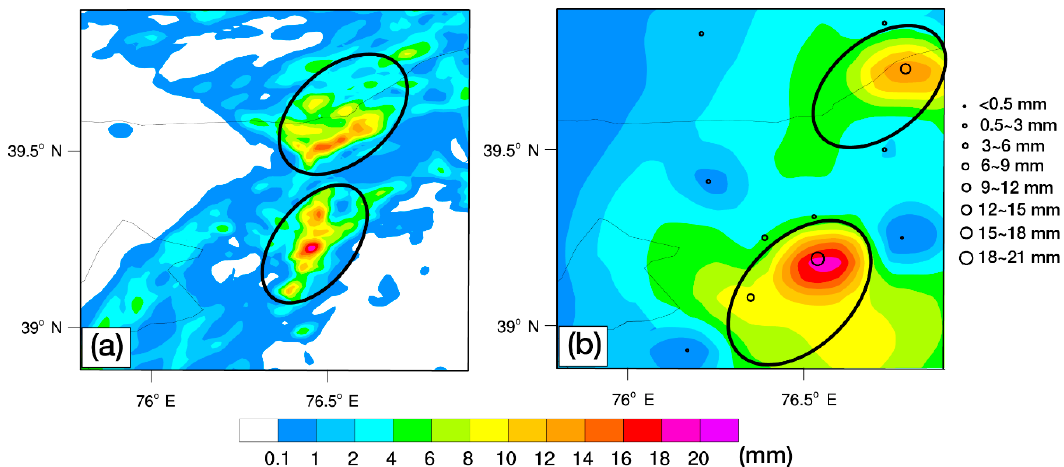
Figure 7. ( a ) Simulated 8-h accumulated precipitation (units: mm) from 1000 to 1800 UTC 23 June 2015. ( b ) 8-h accumulated precipitation (shading, units: mm) observed by the ground-based automatic stations (indicated by small black circles) from 0900 to 1700 UTC 23 June 2015.